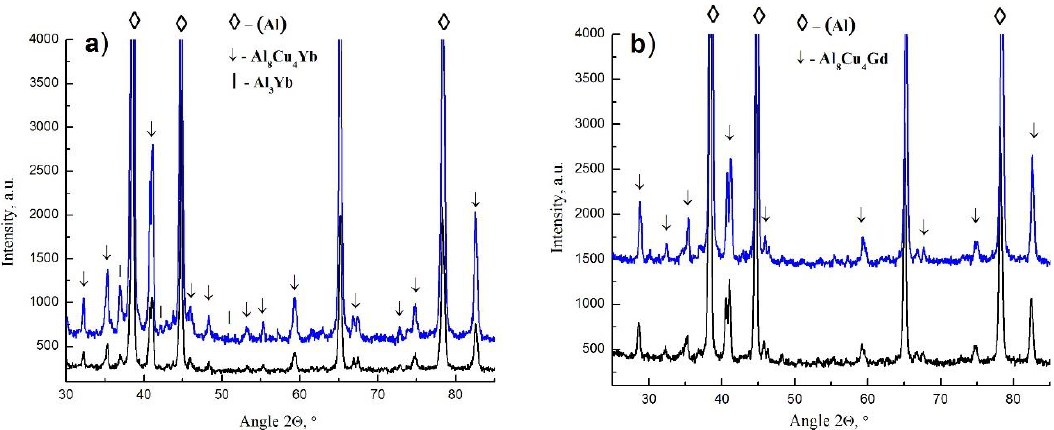
Figure 2. As-cast microstructure of the AlCuYbZr ( a ) and AlCuGdZr ( b ) alloys (SEM).